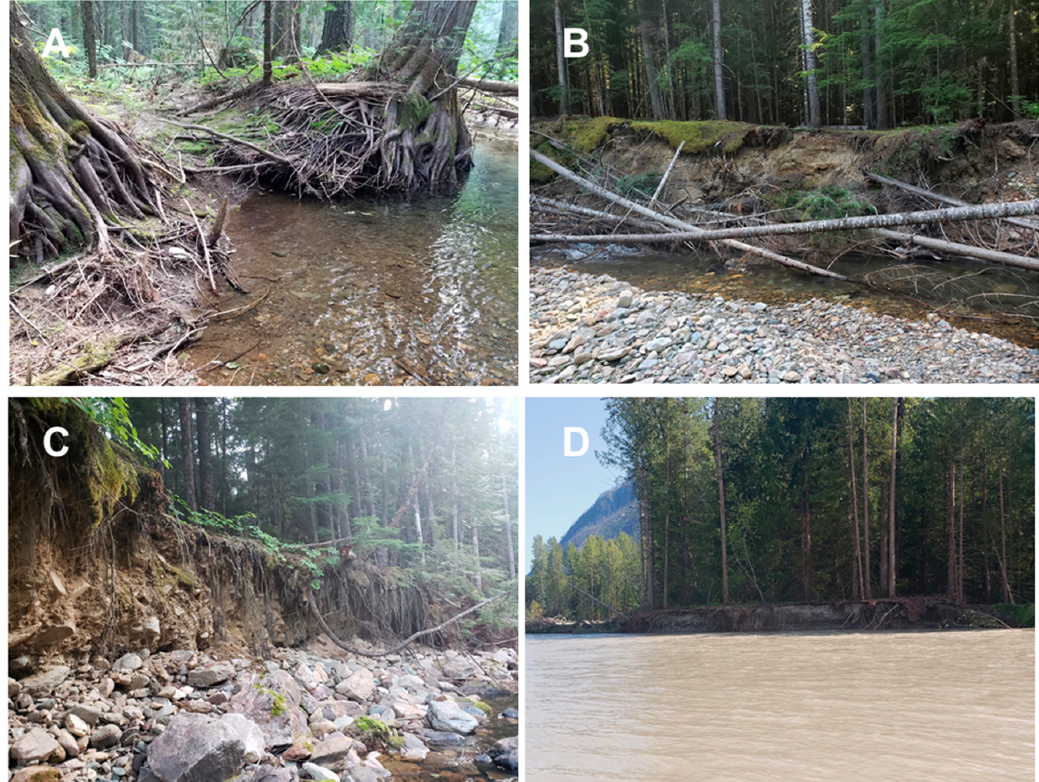
Figure 4. Vegetation and bank erosion/migration. ( A ) Bank reinforcement by the root system; ( B ) Large wood accumulated along the bank; ( C ) Erosion below rooting zone; ( D ) Shallow root system has little effect on erosion, especially in larger rivers with high banks (here during a high flow event).